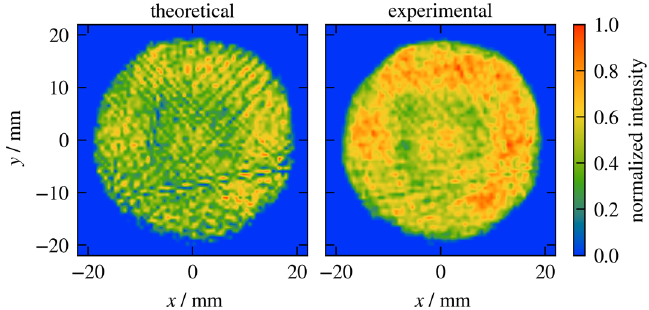
Figure 7. Reconstruction of a round premixed flat methane / air flame using either a theoretically (left) or an experimentally (right) determined projection matrix. (310 nm, exposure time 60 ms, λ 1 = 5, λ 2 = 10, φ = 1.0, V = 12 slm)